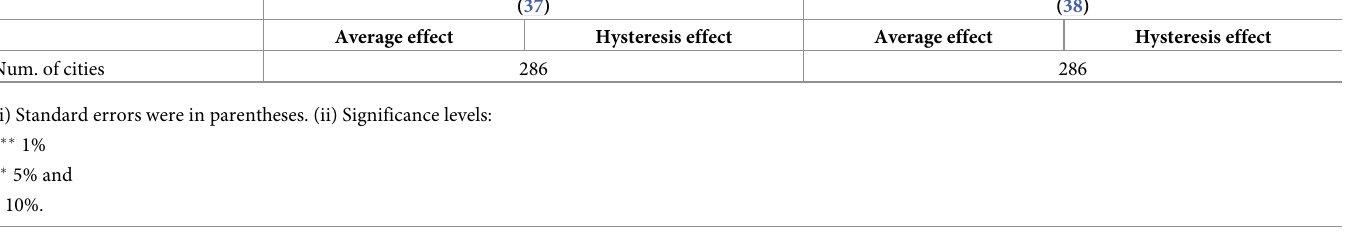
Table 7. For the spatial hysteresis effect, only sectoral structure’s impact was positive and sig- nificant at 1% level, indicating that sectoral structure of a city would play a certain role in